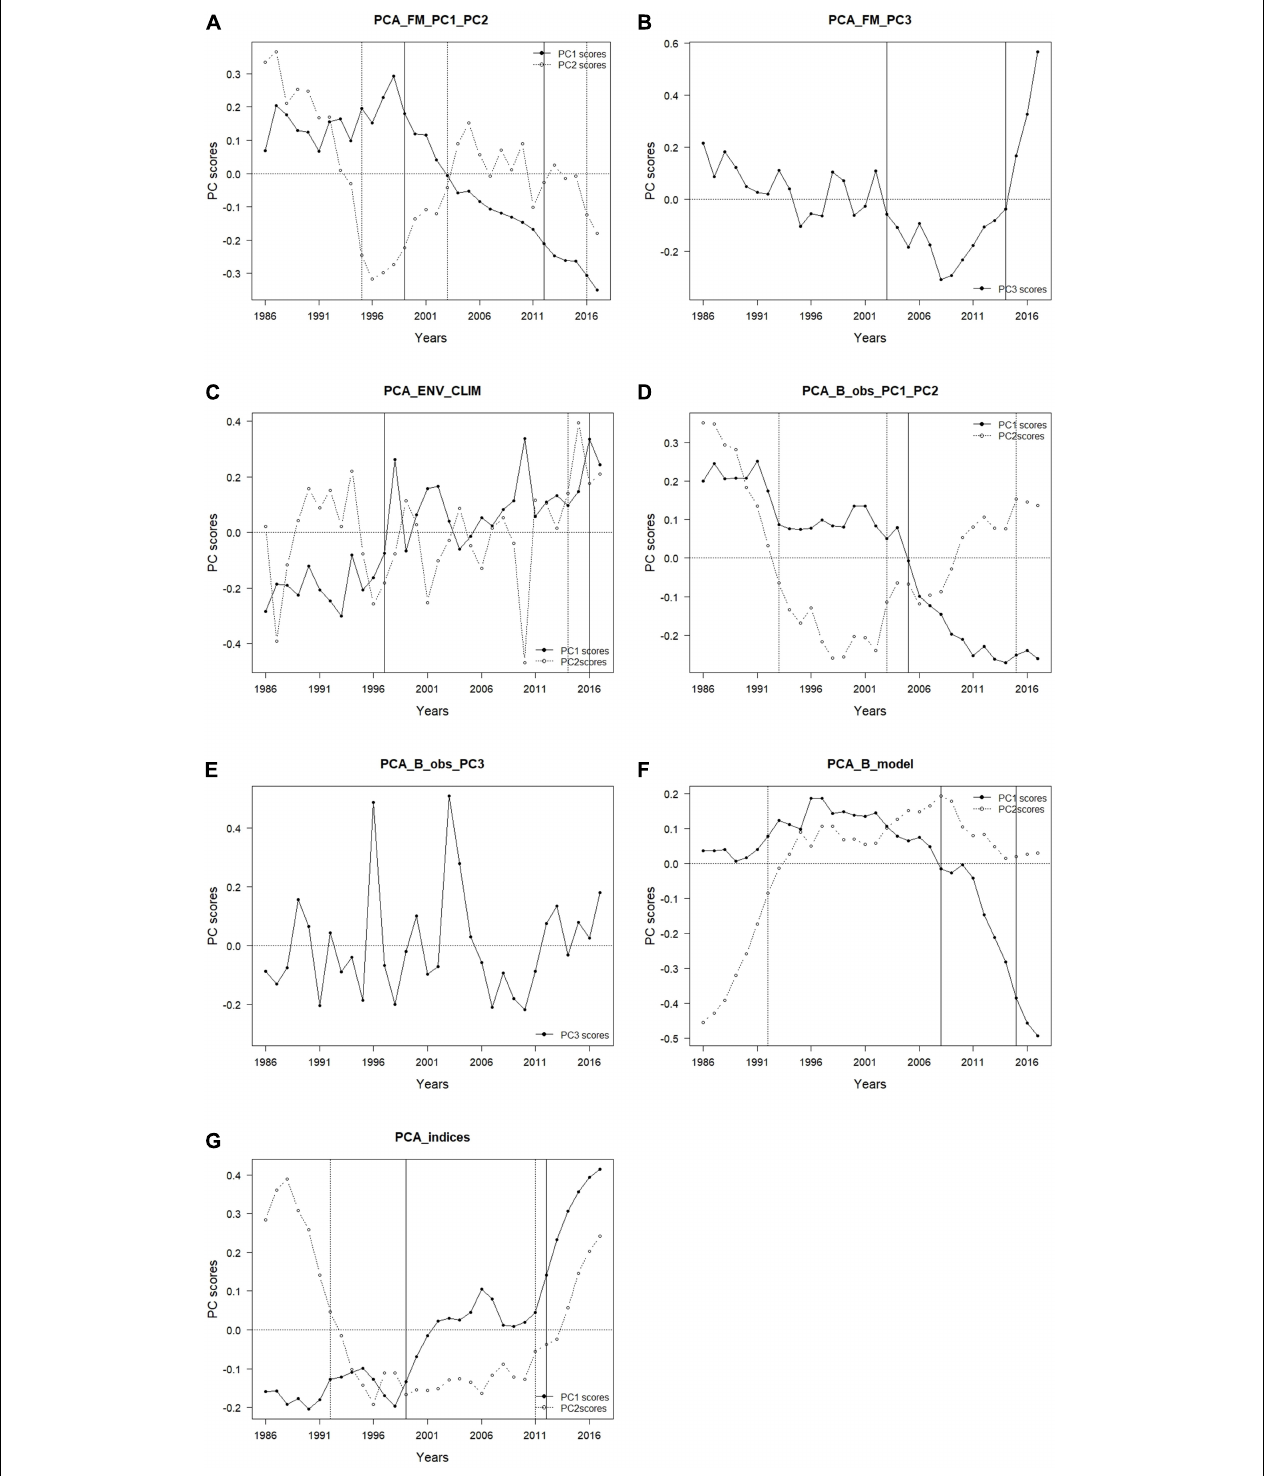
FIGURE 4 | Results of principal component analysis (PCA); time-trajectory of PC scores of PCA performed on (A) fishing mortality PC1 and PC2 (PCA_ FM_PC1_PC2); (B) fishing mortality PC3 (PCA_FM_PC3); (C) environmental/climatic variables PC1 and PC2 (PCA_ENV_CLIM); (D) observed biomass PC1 and PC2 (PCA_B_obs_PC1_PC2); (E) observed biomass PC3 (PCA_B_obs_PC3); (F) modelled biomass PC1 and PC2 (PCA_B_model); and (G) ecosystem indicators PC1 and PC2 (PCA_indices) (black dots – PC1, PC3 white dots – PC2).